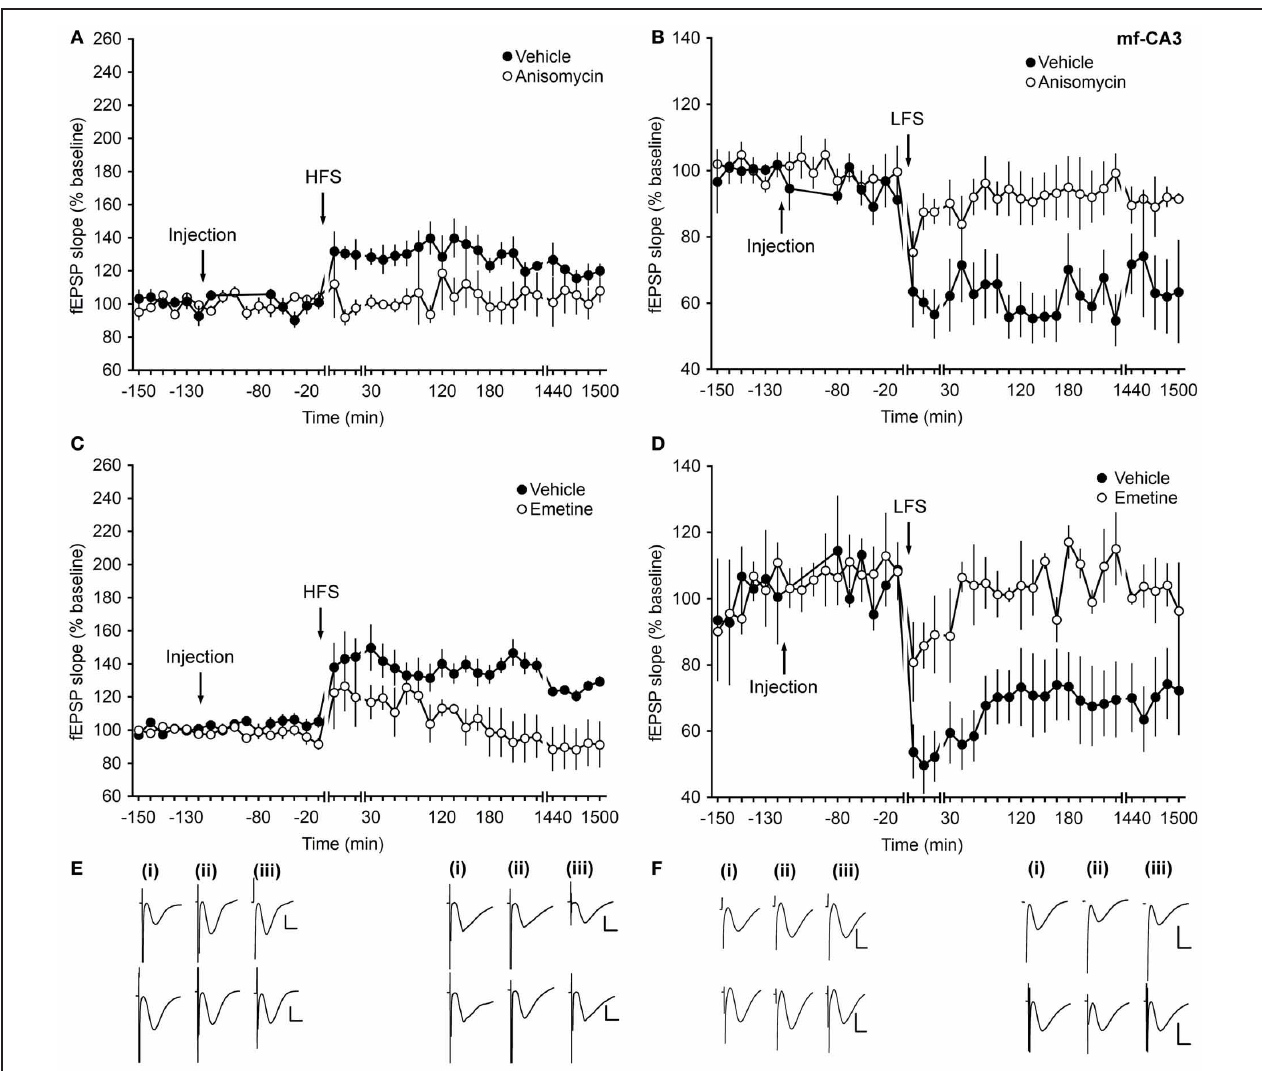
applied prior to HFS (lower traces): analog examples representing pre-HFS (i) , 5min post-HFS (ii) and 24h post-HFS (iii) are shown. Vertical scale bar: 2mV, horizontal scale bar: 8ms. Analog traces in the right panel are recorded during an experiment in which only LFS was applied (upper traces) and during an anisomycin experiment (lower traces) pre-LFS (i) , 5min post-LFS (ii) and 24h post-LFS (iii) . Vertical scale bar: 2mV, horizontal scale bar: 8ms. (F) Analogs in the left panel depict fEPSPs recorded during a control experiment (upper traces) and during an emetine experiment (lower traces) pre-HFS (i) , 5min post-HFS (ii) , and 24h post-HFS (iii) . Vertical scale bar: 2mV, horizontal scale bar: 8ms. Analog traces in the right panel represent recordings taken (i) pre-LFS, (ii) 5min post-LFS, and (iii) 24h post-LFS in the presence of vehicle (upper traces) or emetine (lower traces). Vertical scale bar: 2mV, horizontal scale bar: